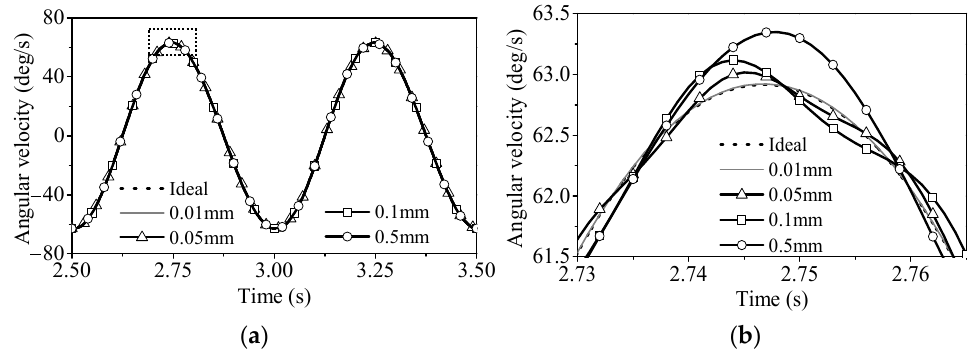
Figure 8. Angular velocity of the rigid system with different clearance sizes: ( a ) angular velocity; ( b ) partial enlarged drawing.